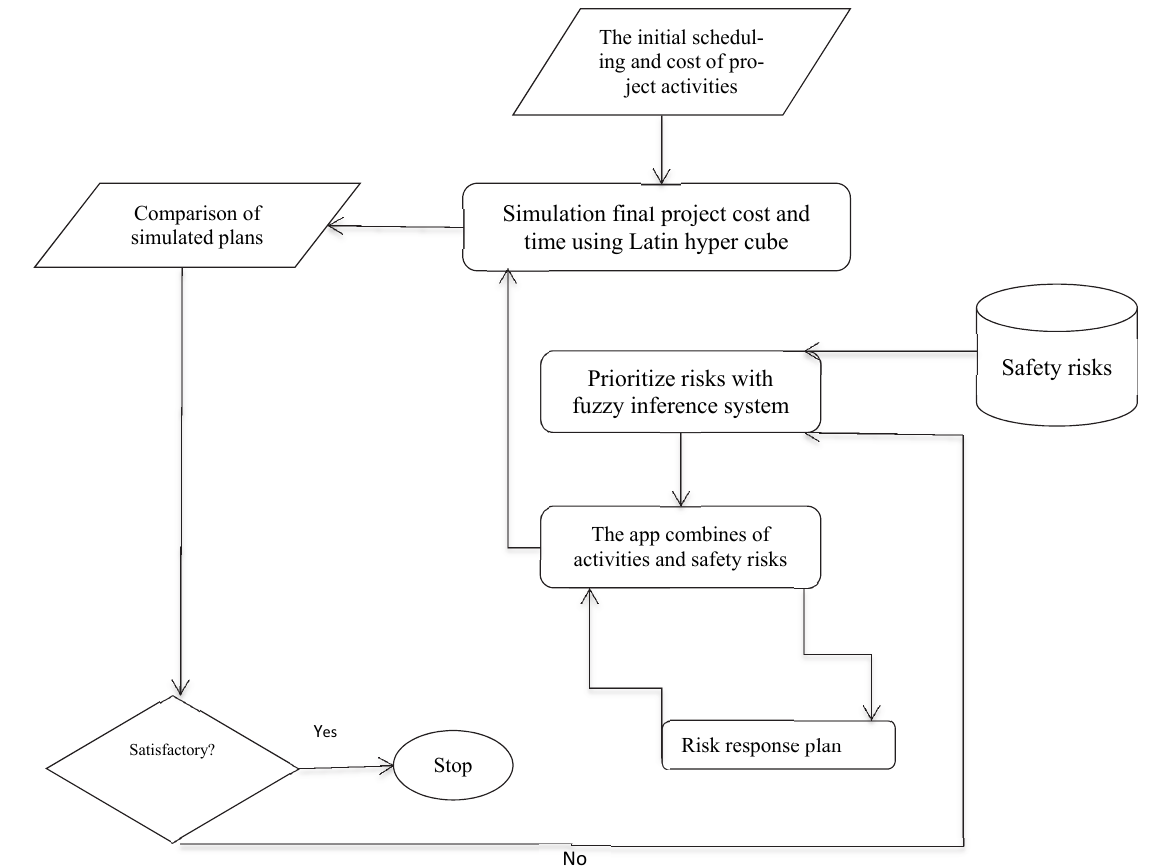
Fig. 2. Suggested hybrid model for study the effects of safety risks on project